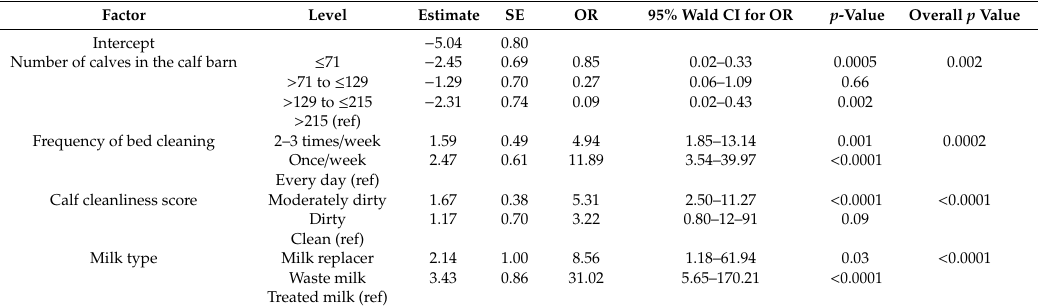
Table 4. Final multilevel regression model for diarrhea in 686 1 calves raised in group pens on 29 farms in Los R í os region,